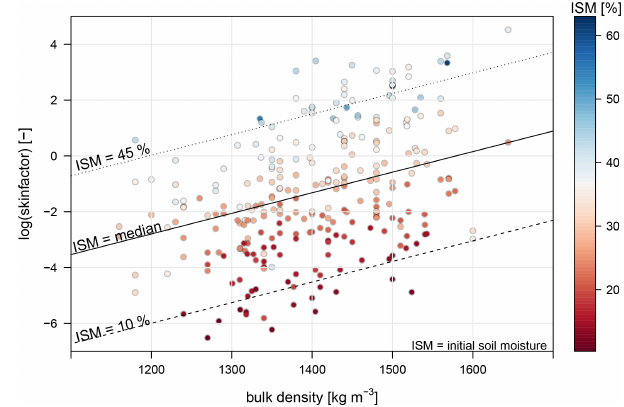
Figure 3. The dependency of the skinfactor on the bulk density and soil moisture. Point data represent the whole dataset with experi- mentally derived skinfactors. Line data represent skinfactor predic- tion by STRONG for three different initial soil moisture conditions. ISM: initial soil moisture. Table 5. Error propagation of the skinfactor prediction models for the surface runoff and sediment mass evaluated by commonly used statistical indicators. ORIG STEP1 STEP2 STRONG Surface runoff